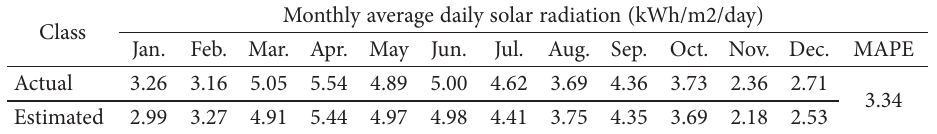
Table 2. Estimation results of the Uiryeong’s MADSR data using the FEM model